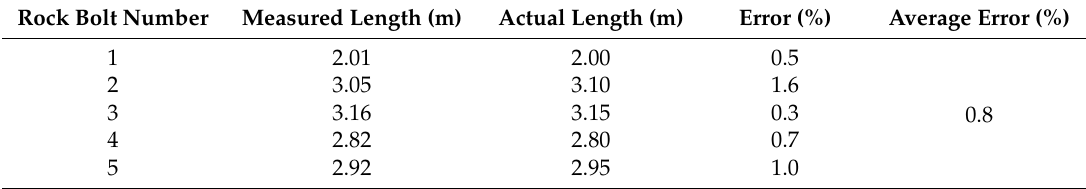
Table 1. The results for five of the chosen rock bolts in a highway tunnel in Wuqi County. Rock Bolt